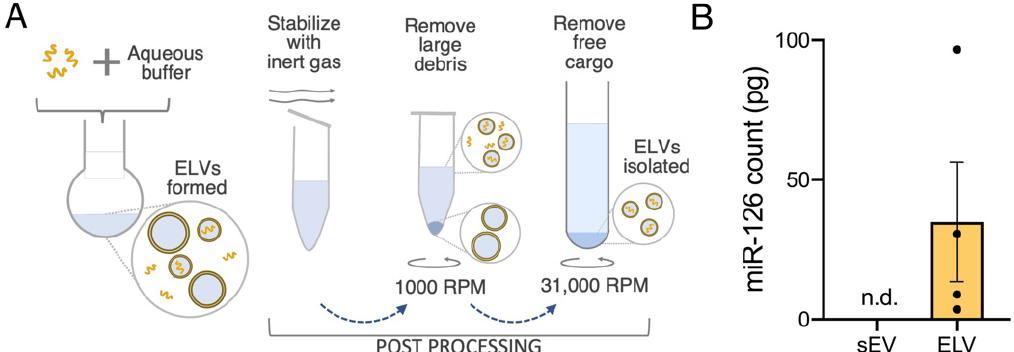
Figure 3. miR-126 was encapsulated into ELVs with the modified TFH. ( A ) Workflow of ELV post-processing to stabilize ELVs, remove larger debris and cargo-free vesicles, remove free unencapsulated miRNA cargo and isolate miRNA+ELVs. ( B ) Quantification of endothelial-specific miR-126 loading into ELVs as compared to presence in sEVs as counts per 1.00 × 10 6 particles. n = 4 represent biological replicates. Mean ± SEM. n.d. = not detected.